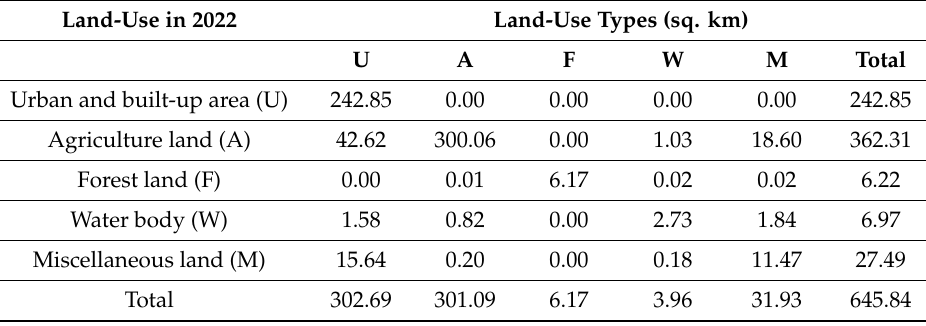
Table A9. Transition area matrix for land-use change between 2018 and 2022. Land-Use in 2022